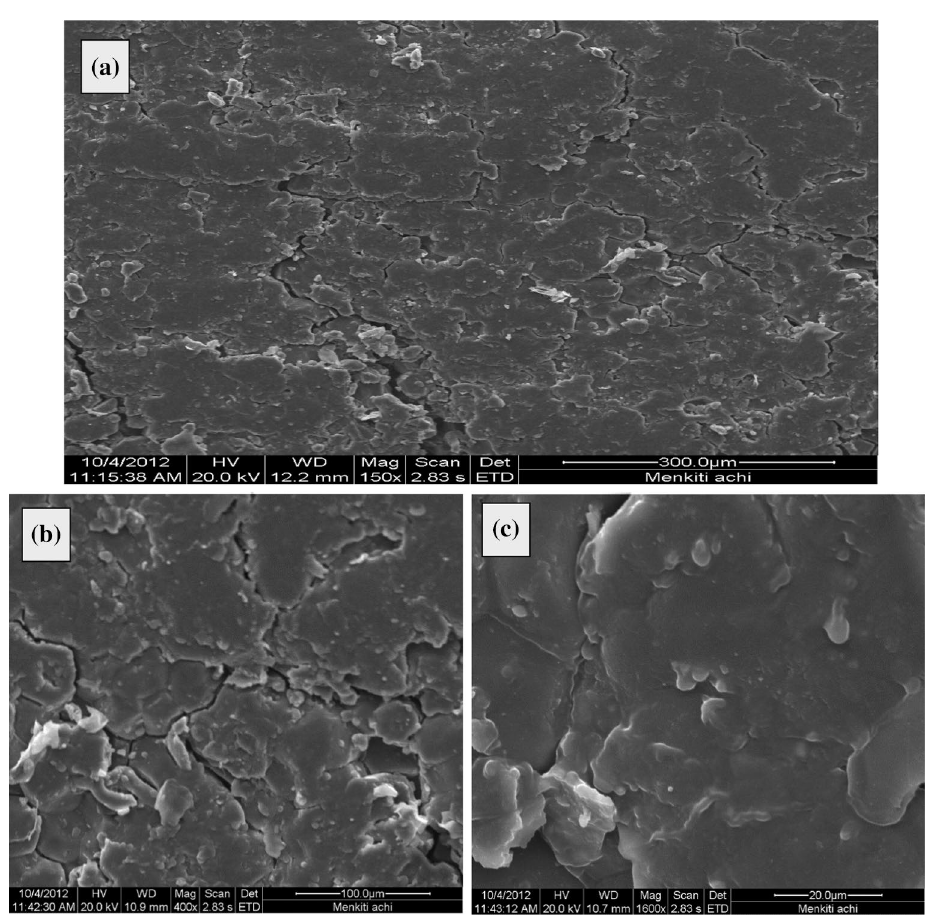
Fig. 1 a – c SEM images of BEC precursor sample at × 150, × 400 and × 1600 magnifications